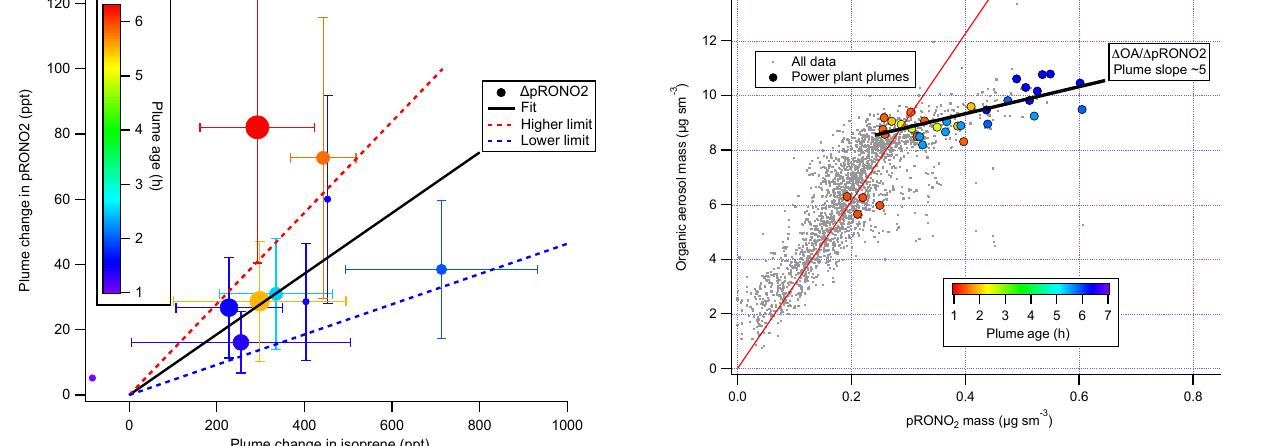
Figure 5. SOA molar yield can be determined as the slope of (cid:49) pRONO 2 vs. (cid:49) isoprene, both in mixing ratio units. The linear fit is weighted by square root of number of points used to determine each in-plume pRONO 2 , with intercept held at zero. The slope co- efficient ± one standard deviation is 0 . 0930 ± 0 . 0011. Larger “out- side” high and low limits of the slope (shown as dashed red and blue lines) are obtained by adding and subtracting from this slope the combined instrumental uncertainties, based on adding in quadrature the PTR-MS uncertainty of 5% and the AMS uncertainty of 50%. This gives an overall uncertainty of 50.2%, resulting in upper and lower limit slopes of 0.140 and 0.046, respectively. Points are col- ored by plume age, and size scaled by square root of number of points (the point weight used in linear fit). This plot and fit includes the nine plumes listed in Tables 1 and 2, as well as the 03:14 “unre- acted” plume (at (cid:49) isoprene =− 84ppt). Error bars on isoprene are the propagated standard deviations of the (in plume–out plume) dif- ferences, for plumes in which multi-point averages were possible. Error bars on pRONO 2 are the same as in Fig. 4, converted to ppt. The points without error bars are single-point plumes.